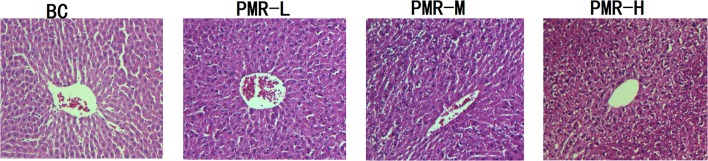
Representative light photomicrographs of rat liver specimens for HE analysis (400* magnification).